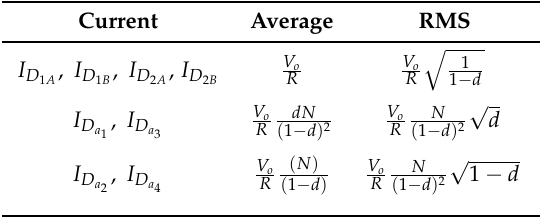
Table 3. Diode average and RMS currents.